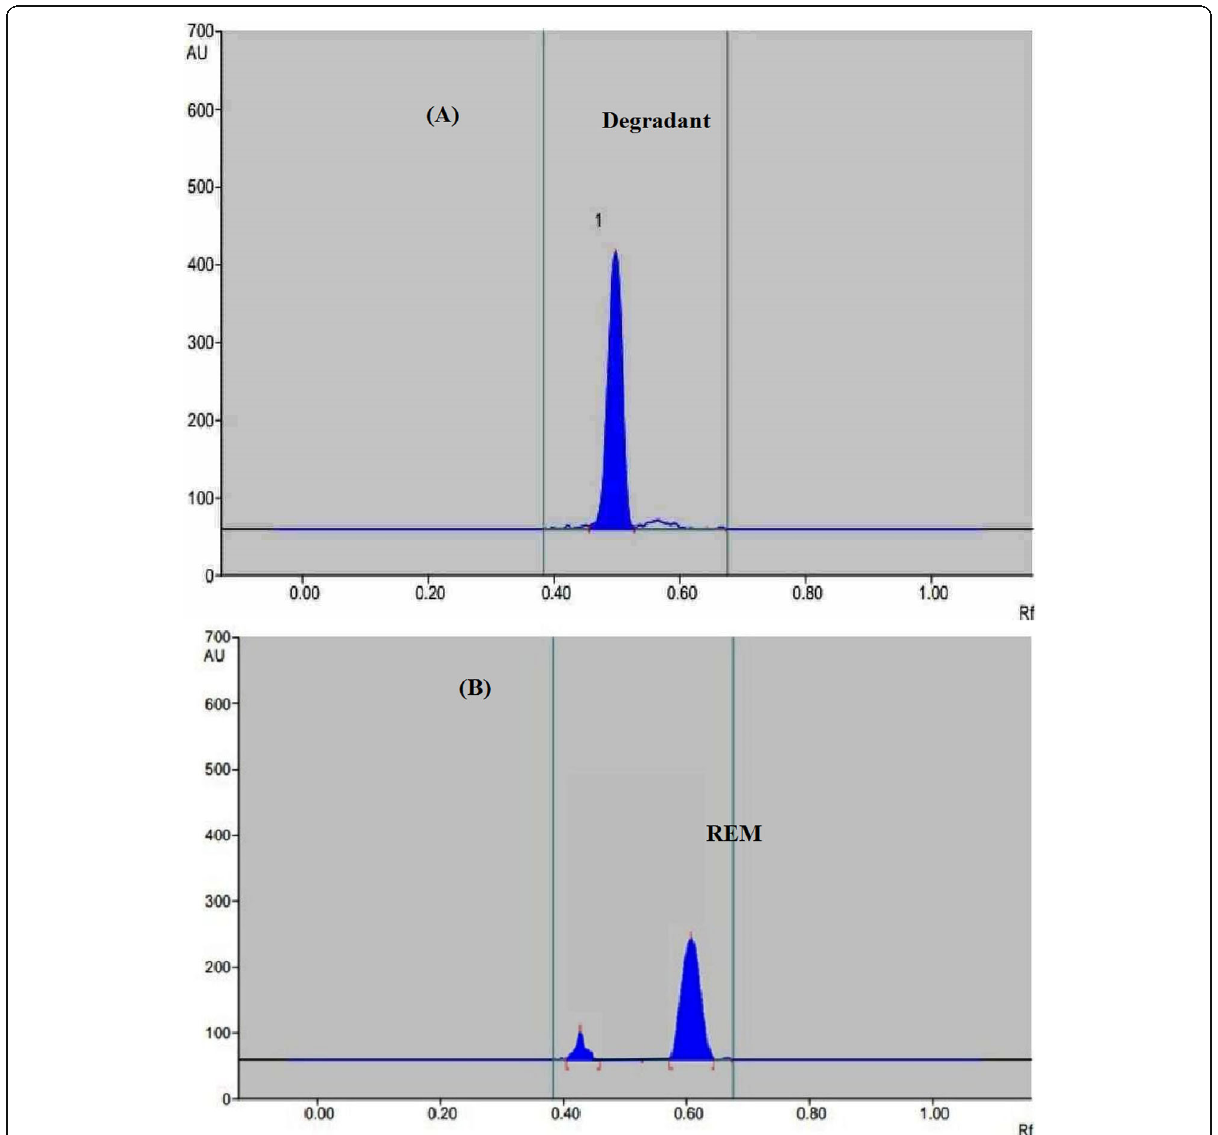
Fig. 5 Densitogram of forced degraded samples. a 0.1N NaOH-treated REM for 30 min at 25 °C and b 0.1N NaOH-treated REM for 5 min at 25